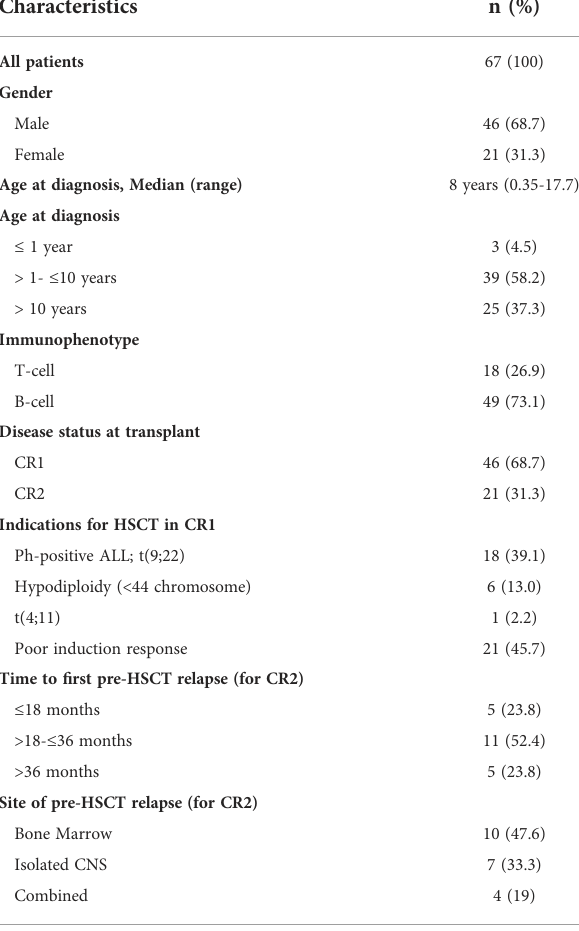
TABLE 2 Clinical and biological characteristics of the 67 ALL patients.